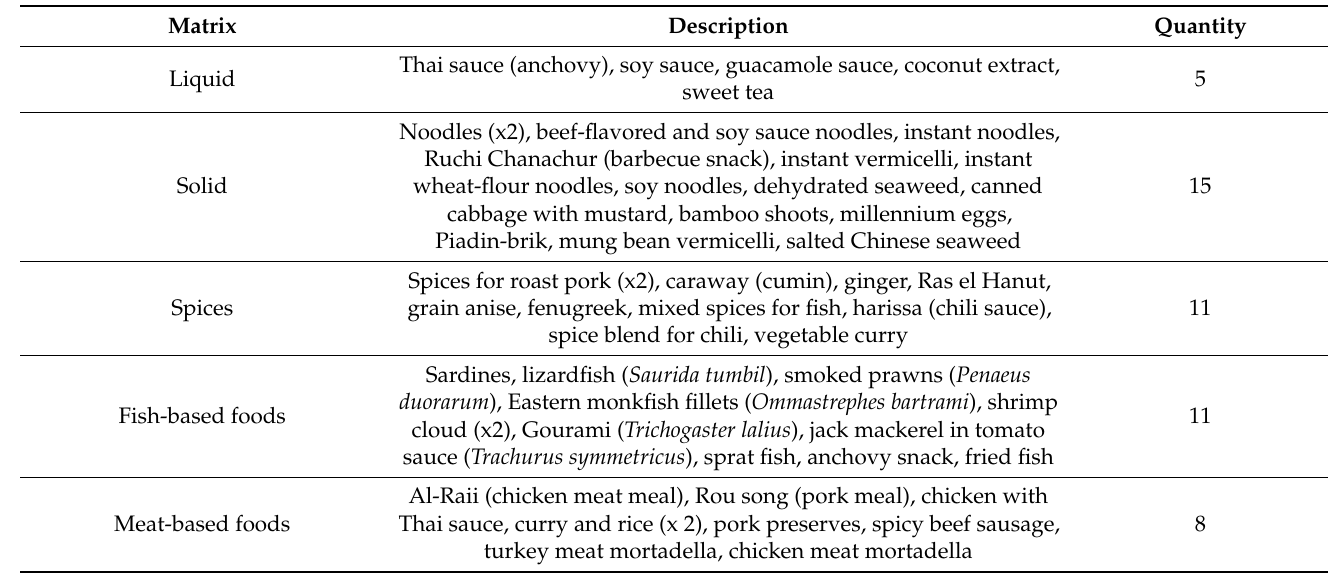
Table 1. Classification of food matrices.